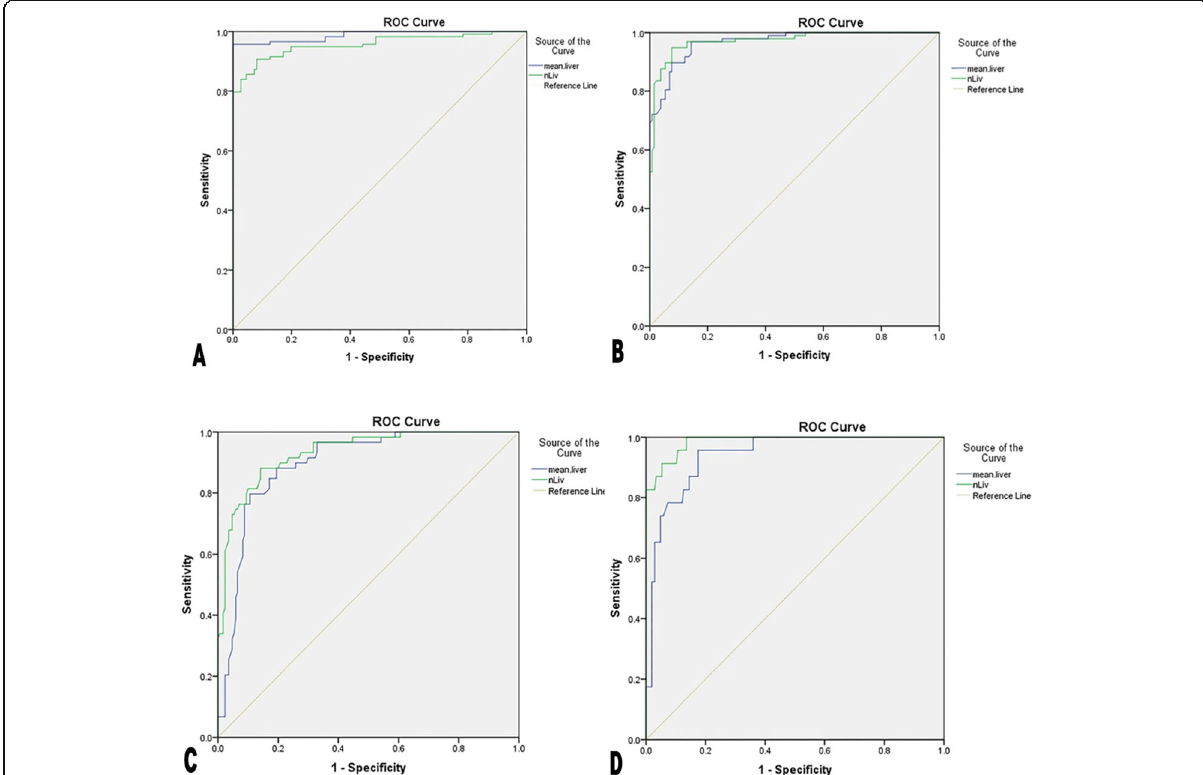
Fig. 6 Receiver operating characteristic (ROC) curve for liver ADC and normalized liver ADC in diagnosis of fibrosis stage ≥ F1 ( a ), ≥ F2 ( b ), ≥ F3 ( c ), and F4 ( d